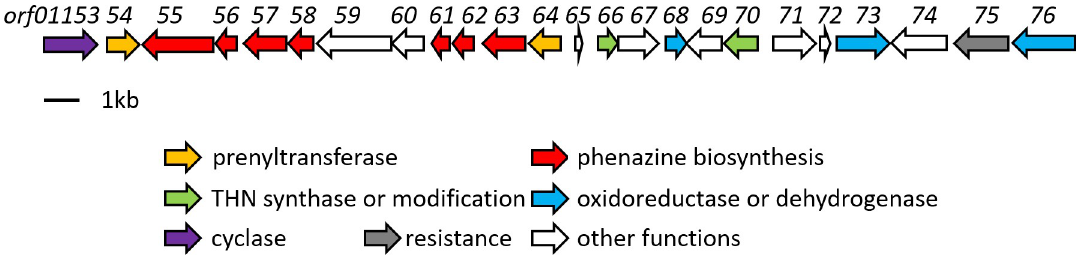
Fig 3. Organization of the gene cluster of compounds 1–6 in S . niveus SCSIO 3406.